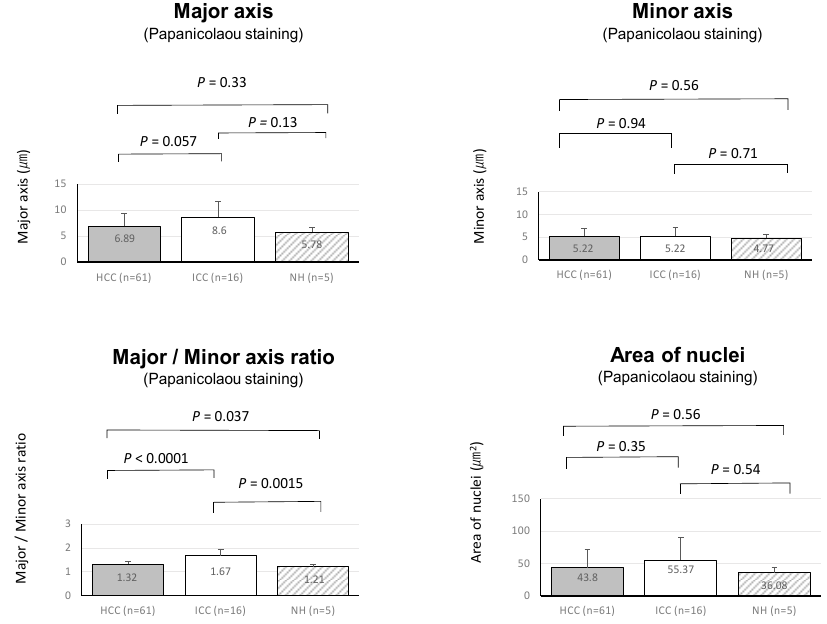
Figure 3. Comparison of major axis, minor axis, major/minor axis ratio and the nucleus area of hepato- cytes cellular carcinoma (HCC), intrahepatic cholangiocarcinoma (ICC) and non-tumorous hepatocytes (NH).